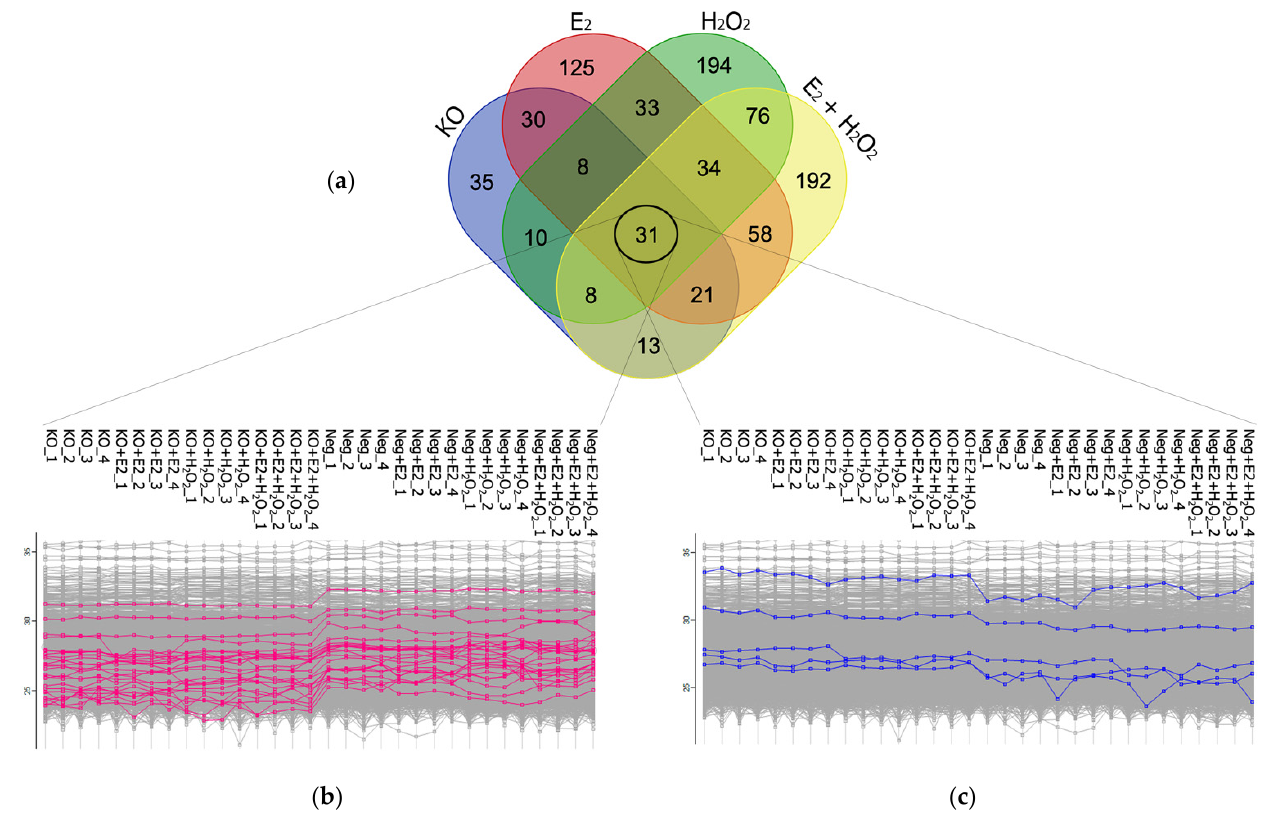
Figure 3. Eulero–Venn analysis of the differentially regulated proteins in the four analyzed conditions focusing on common proteins. ( a ) The Eulero–Venn analysis returned 31 regulated proteins as being in common for all the conditions. All the proteins showed the same trend of abundance throughout the replicates, except for one that was discarded. In detail, ( b ) 25 out of 30 proteins showed low abundance while being downregulated in all the NGB-KO conditions, and ( c ) 5 out of 30 proteins showed high abundance while being upregulated in all the NGB-KO conditions. Table 3. Common protein dataset in all NGB-KO comparisons with fold changes. Protein Fold Change